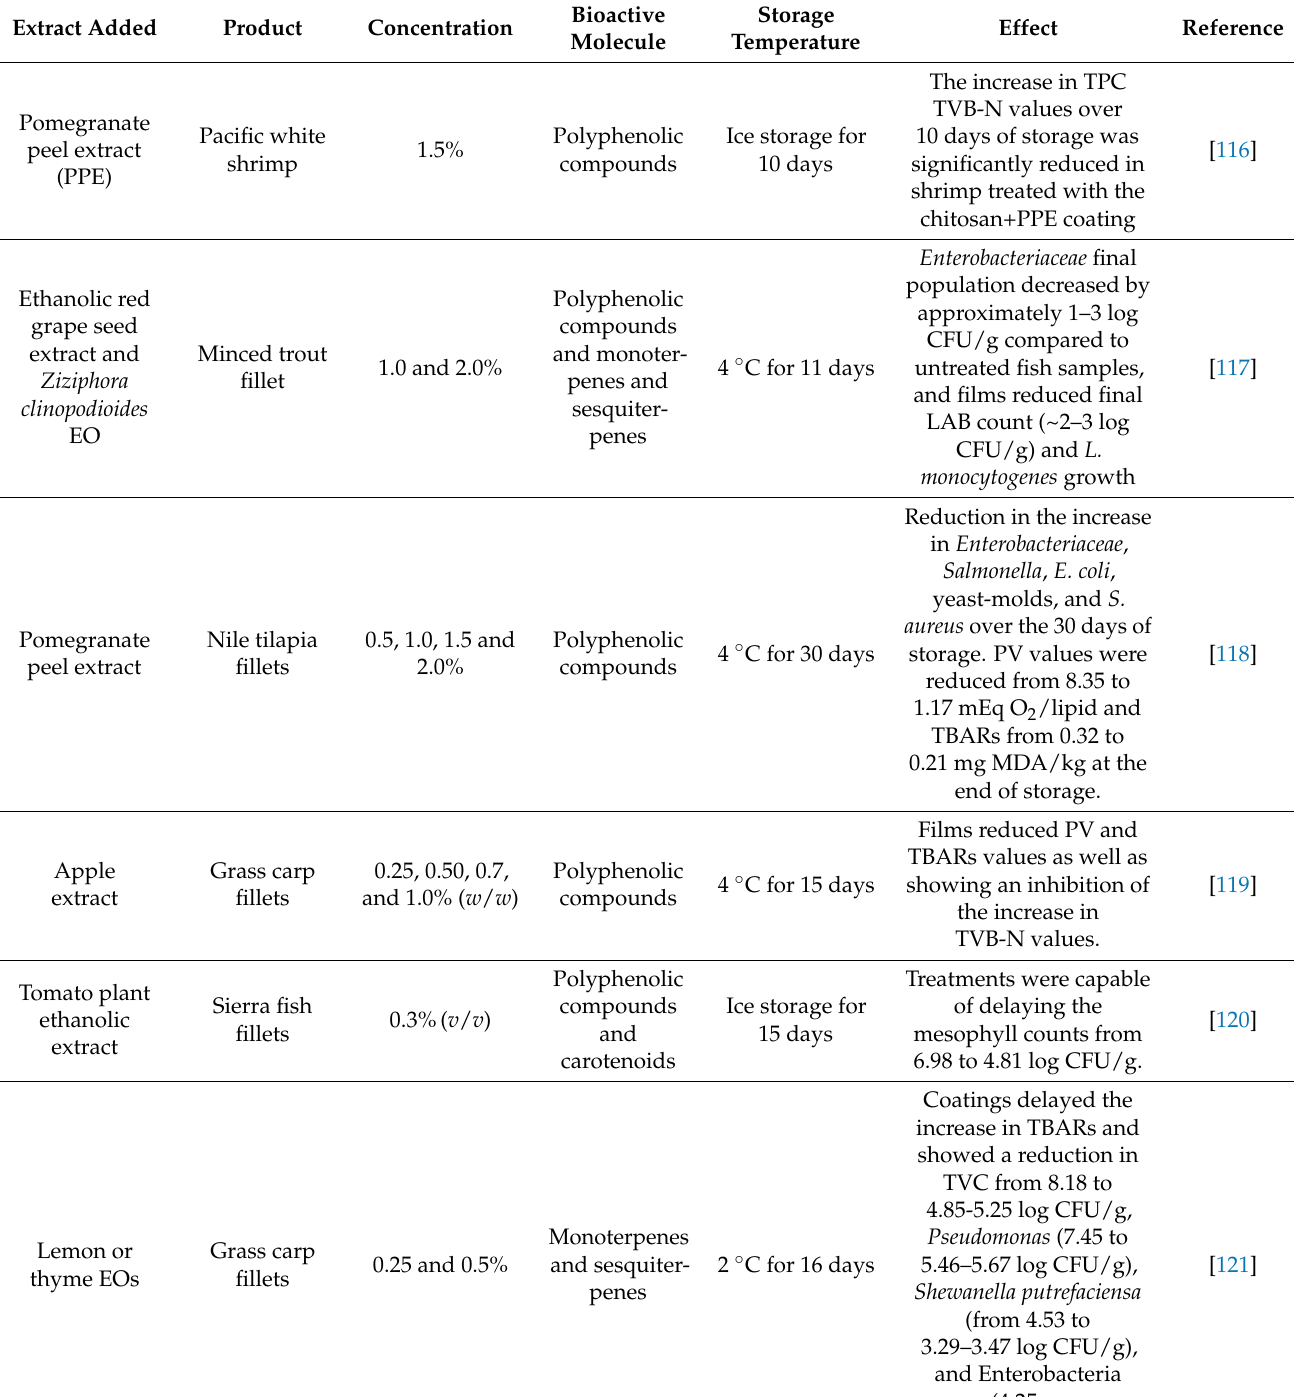
Table 4. Natural extracts added to chitosan-based films and coatings for fish and seafood